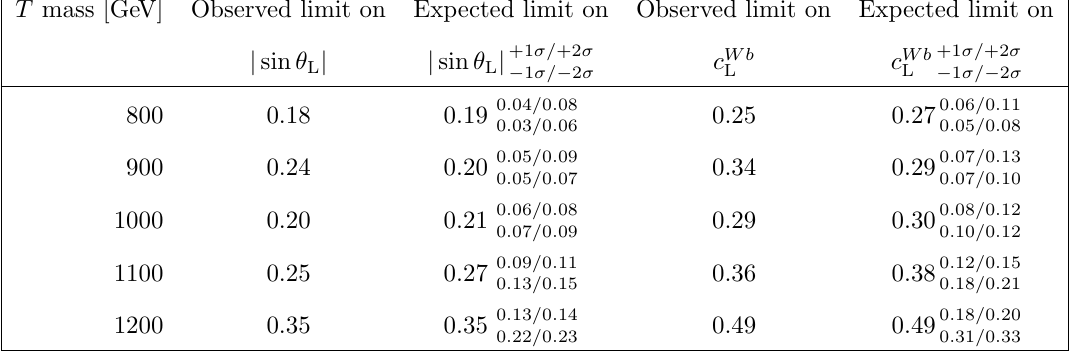
Table 5. Observed and expected 95% CL upper limits on quark in a T singlet model with masses of 800 GeV to 1200 GeV assuming